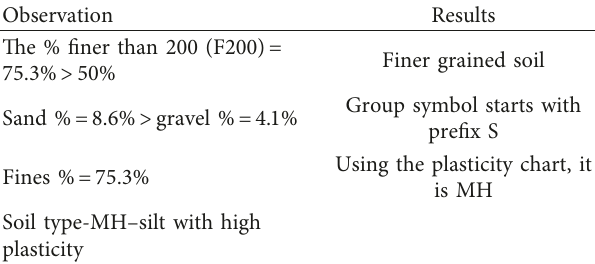
Table 6: Soil type classification under (USCS) (Das 2004).